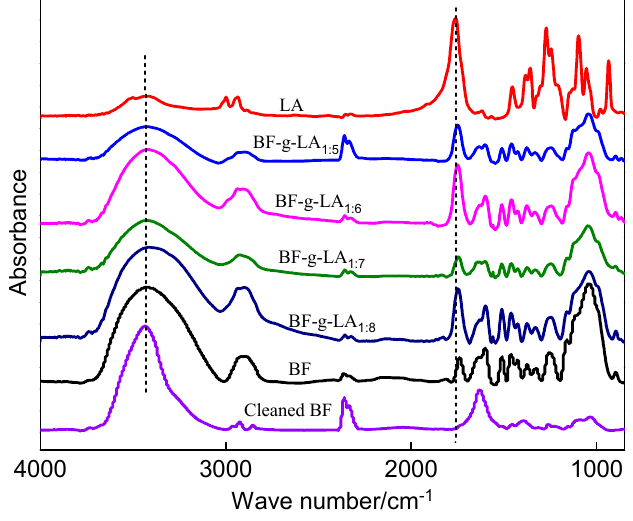
Figure 2. Infrared spectra of BF- g -LA. Table 3. Infrared absorption peaks of the main groups.